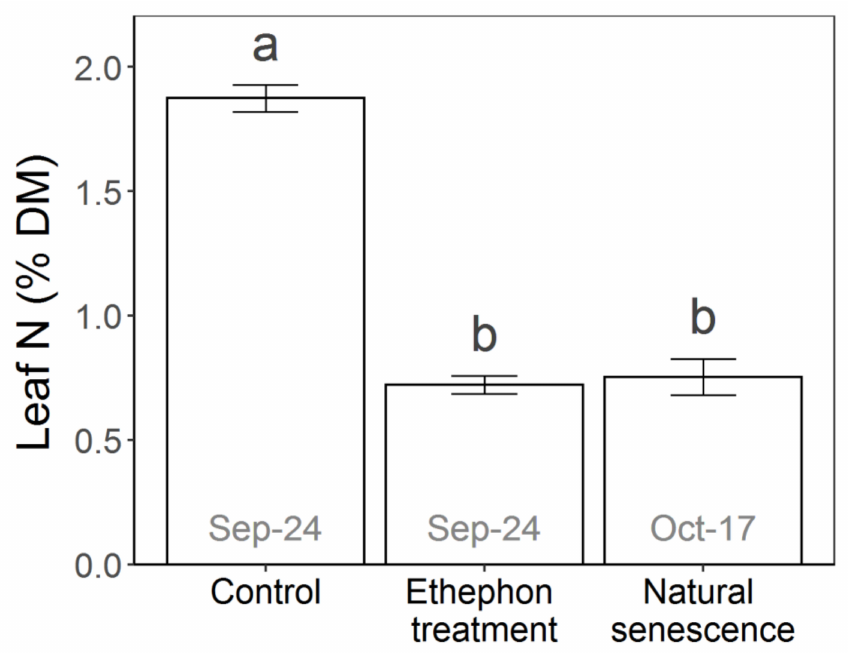
Figure 6. Mean total N concentration ± standard deviation in leaves of control, ethephon-treated and naturally senescing Vitis vinifera cv. Riesling vines. Leaves were sampled on two different dates as stated at the bars, at complete yellowing of the ethephon-treated (control and ethephon treatment) and at complete yellowing of the naturally senescing leaves. Experimental treatments with different letters on top differ significantly with p <